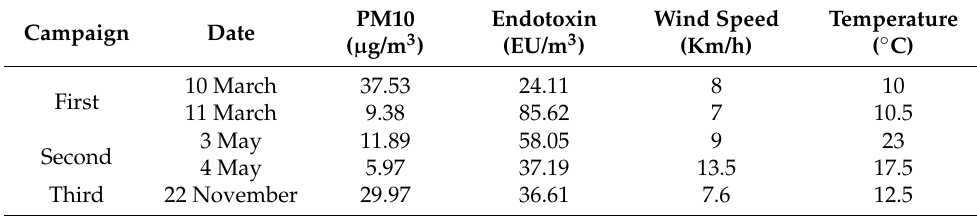
Table 2. PM10 and endotoxin concentrations divided by campaign.